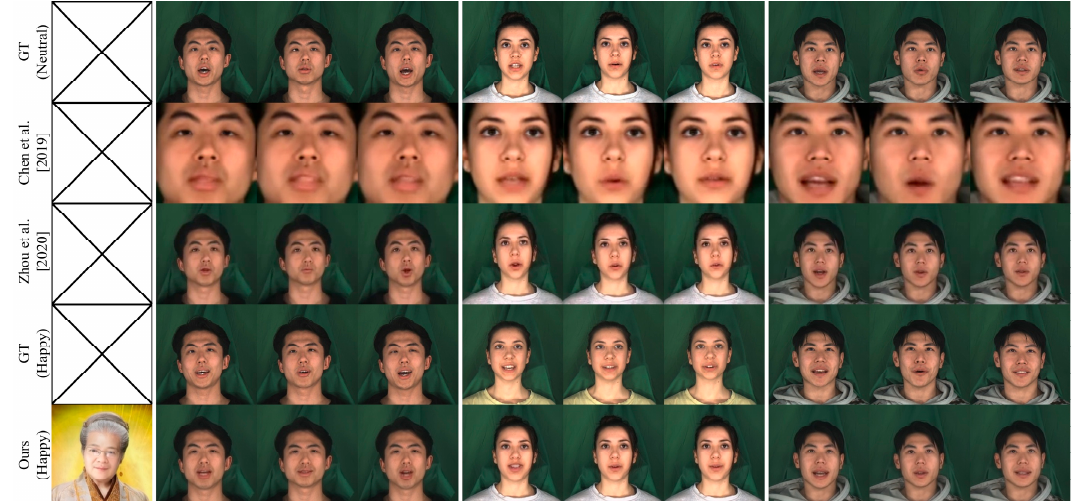
Figure 3. Qualitative comparison with the state-of-the-art methods. All the methods in the figure are based on image generation animation. The input images are all the first frames of the target video; the input videos are all the same speech; and our method additionally selects the unseen portrait as the emotion source.